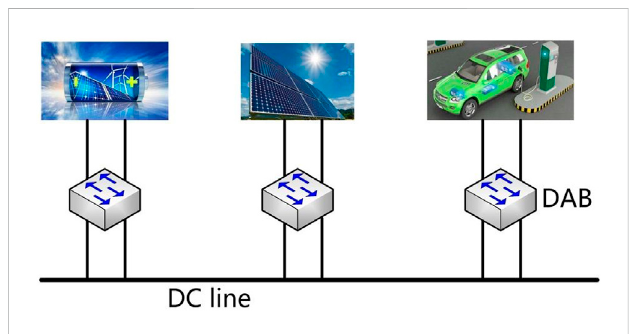
FIGURE 1 The DAB converter applied to small DC power grid topology.